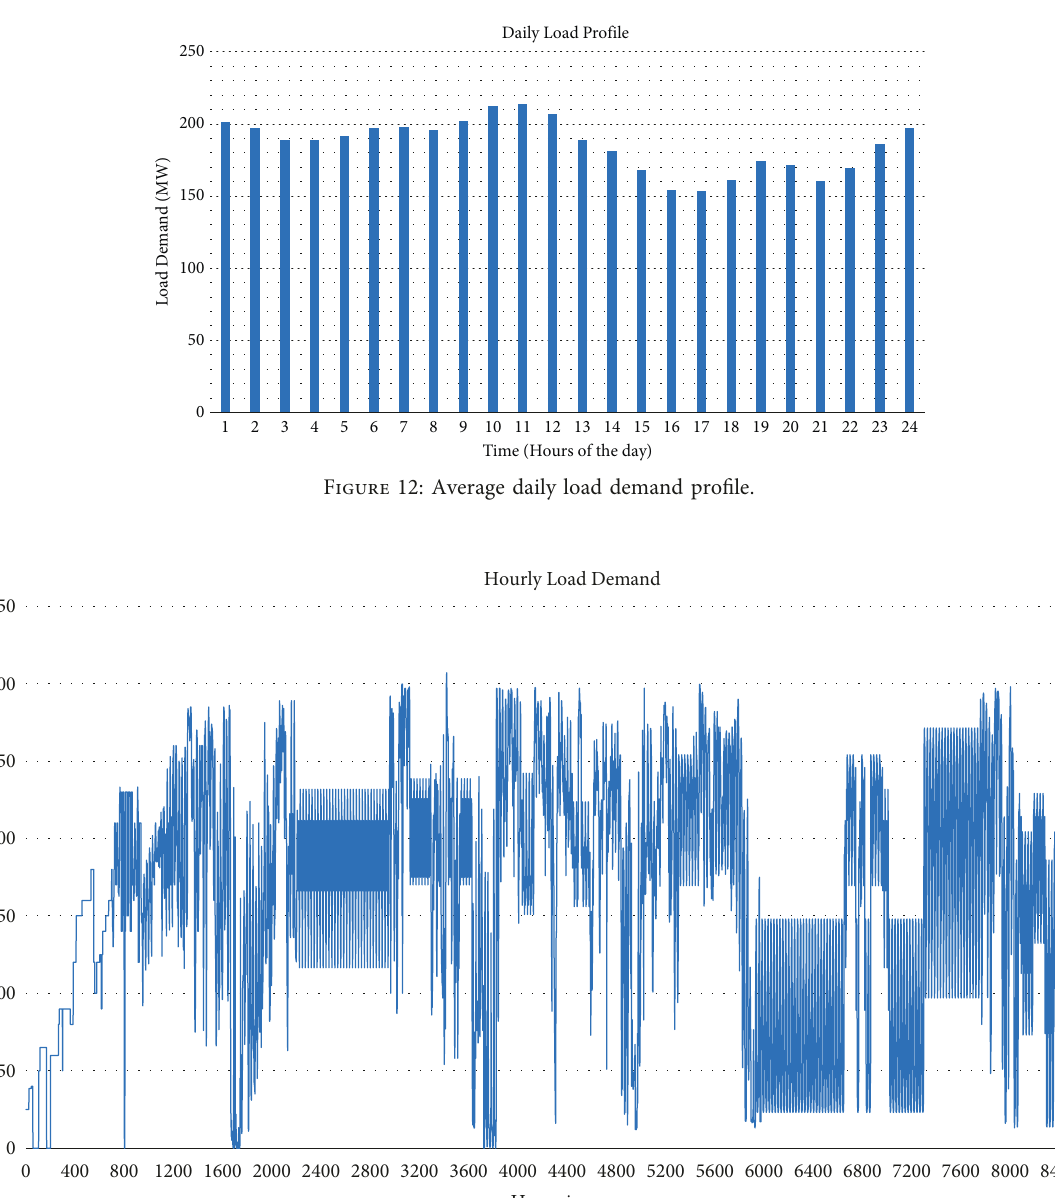
Figure 13: The hourly load demand in a year allocated for